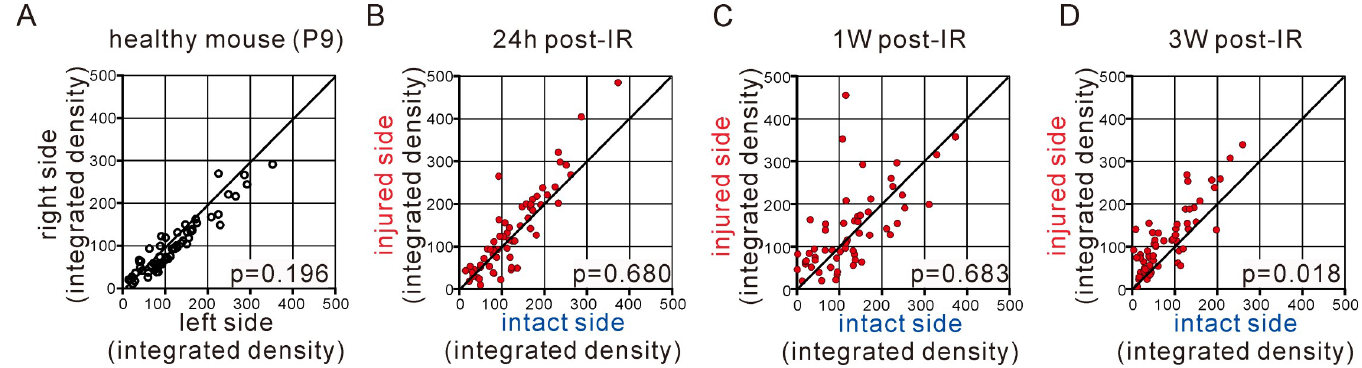
Fig 2. Ischemia-reperfusion (IR) brain damage promoted cytokine/chemokine expression in the injured side. (A) Expression levels in healthy mice (P9, right vs left side brain) are shown as reference controls. (B-D) Plots are depicted as expression levels in the intact side on the x axis and in the injured side on the y axis after 24 hours (B), 1 week (C), and 3 weeks (D) post-IR. Data are the mean of expression levels in tissue lysate detected as integrated density. The p values comparing between injured side and intact side were indicated. P9, 9 days postnatal.